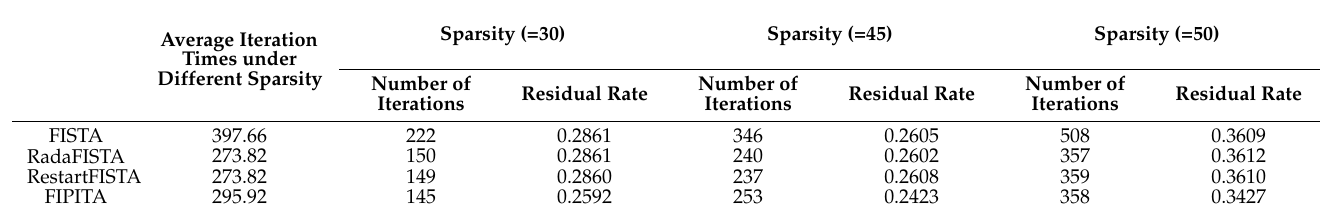
Table 1. Comparison of reconstruction residual rate and iteration numbers of four algorithms.